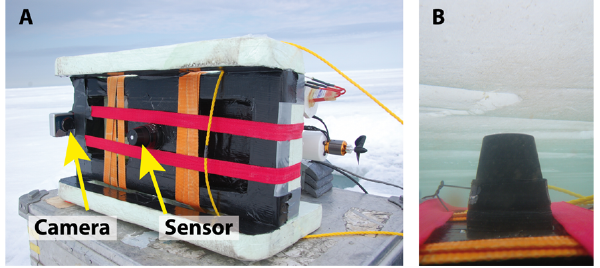
Fig. 1. (a) Sled lying on its side with radiometer in the center, a backward-looking on-board camera, and the yellow tether line at the back of the sled. The straps tie the propulsion to the sled (motor, speed controller and weights). (b) Photograph taken by the on-board camera during under-ice operations in June. The underside of the ice close to the sensor is white while ice in the distance appears to be cyan presumably because of preferential absorption of red light in water.